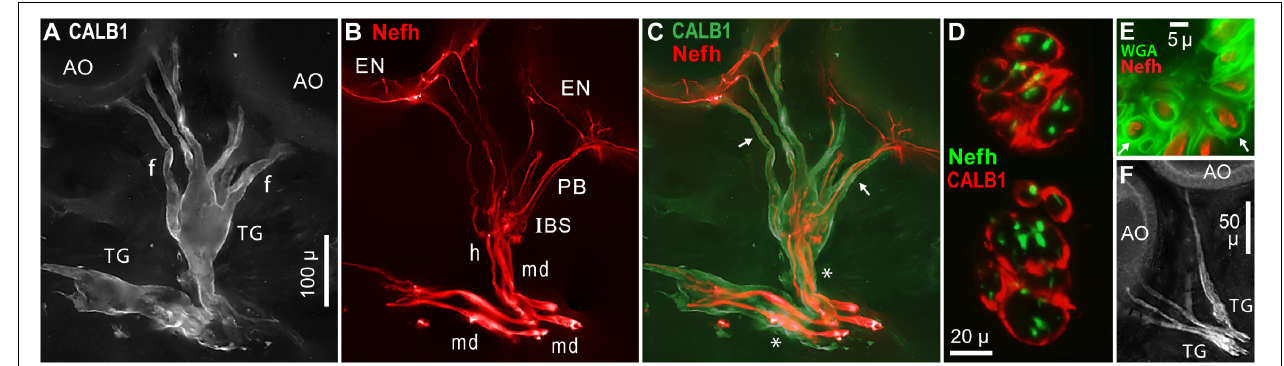
FIGURE 10 | Terminal glia encased unmyelinated arbors. (A) Two terminal glial (TG) cells were labeled by anti–calbindin (CALB1); monochrome fluorescence. These terminal glia projected finger-like processes (f) toward ampullary organs (AO). (B) Parallel afferents were labeled by anti–neurofilament-H (Nefh), pseudocolored red, including short segments of enlarged afferent myelinated dendrites (md), a tapered zone of inferred heminodes (h), inline branching structures (IBS), unmyelinated fibers of projection bundles (PB), and radial arbors in electrosensory neuroepithelia (EN). (C) Merged view of (A,B) , pseudocolored. Calbindin+ glial fingers (arrows) visibly enclosed Nefh+ neurites. , Glia-on-glia organization; see R ESULTS text. (D) Sections across two IBSs showed CALB1+ terminal glial folds surrounding Nefh+ sensory neuron processes. (E) Section across a projection bundle, pseudocolored. The outer sheaths (basal lamina, arrows) of terminal glia fingers were labeled by wheat germ agglutinin (WGA). Subdivisions of the Nefh+ afferent fibers are visible. (F) Anti–NMDAR1 labeling of terminal glial (TG). (A–C) 20x 0.5 NA lens. (D) 40x 0.7 NA lens. (E) 100x 1.25 NA lens. (F) 10x 0.3 NA